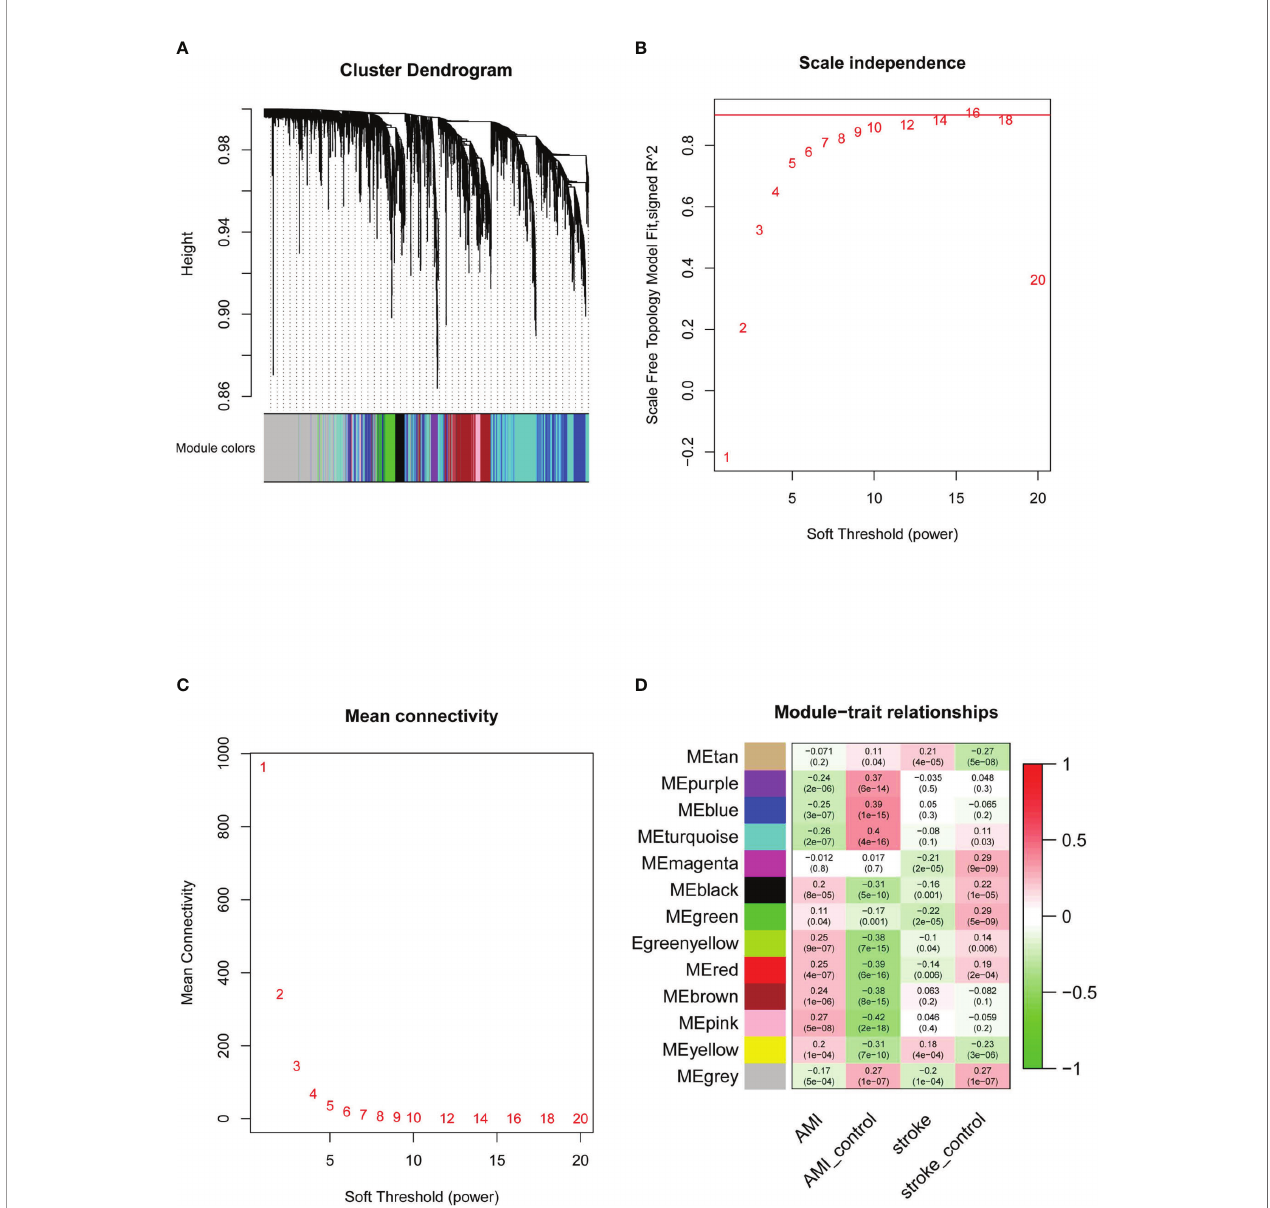
FIGURE 3 | Determination of WGCNA soft-threshold power and identi fi cation of modules associated with AMI and IS. (A) Dendrogram of DEGs clustered on the basis of the measurement of dissimilarity (1-TOM). The color band indicates the results from automatic single-block analysis. (B) Scale-free index analysis for various soft-threshold powers. (C) Mean connectivity analysis for various soft-threshold powers. (D) Heatmap of the correlation between modules and diseases. TOM, topological overlap matrix; ME, module eigengene. Statistical signi fi cance was determined by t